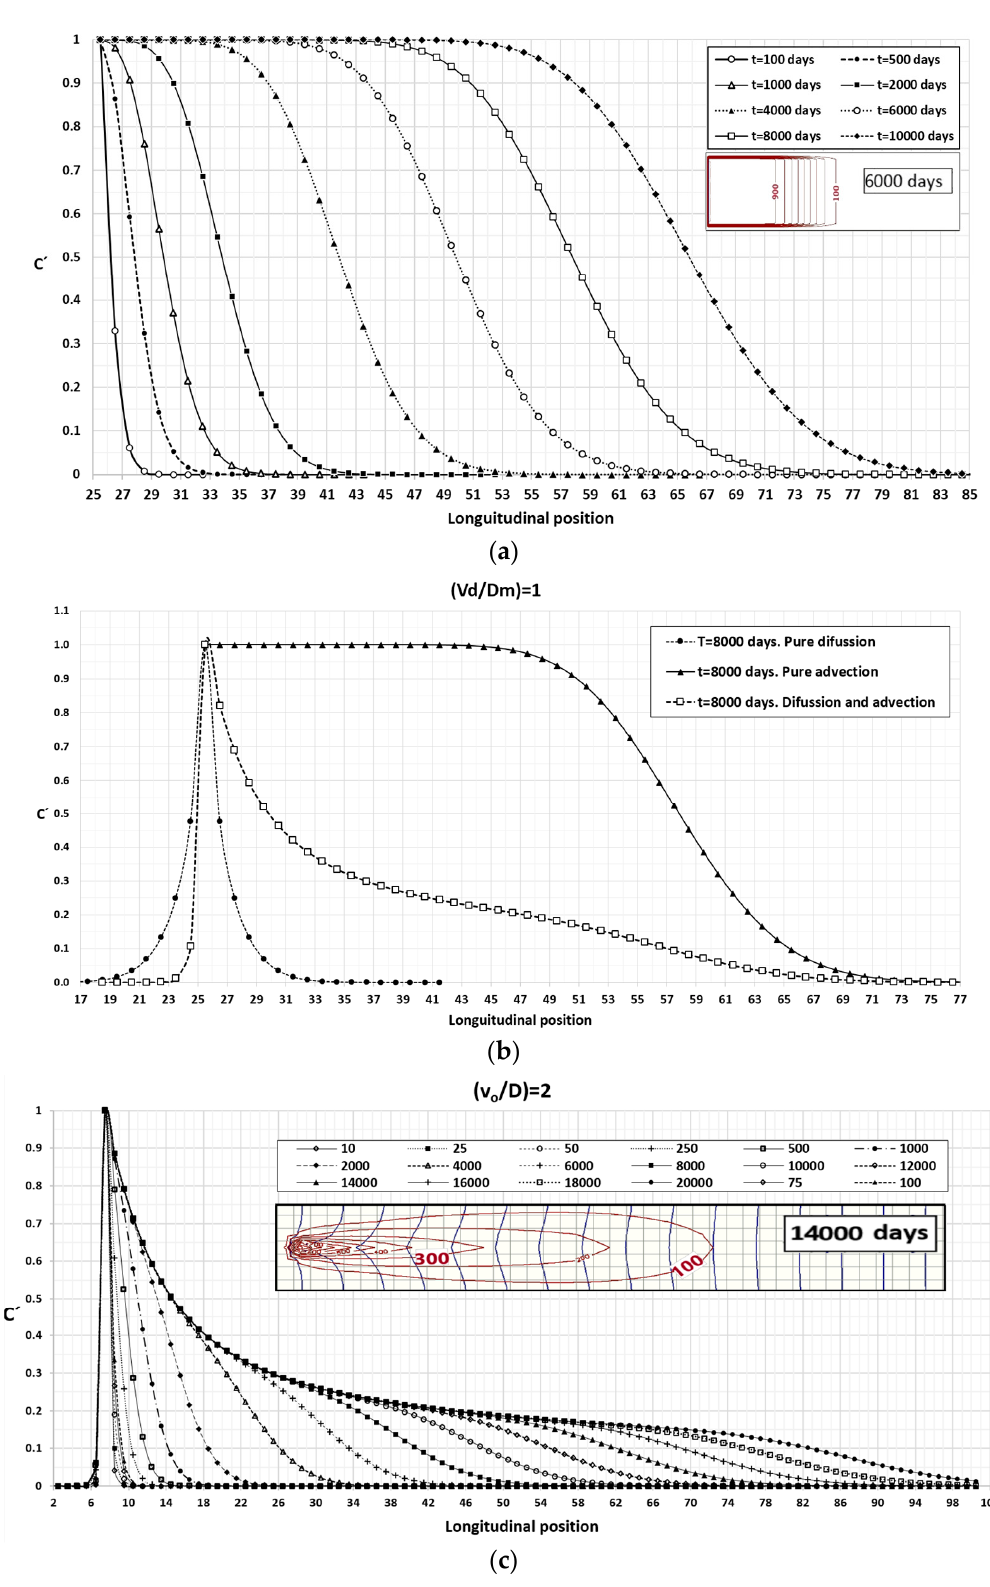
Figure 6. Concentration profiles. ( a ) Only advection, c = 1000 kg/m 3 and vo = 0.0006 m/d. ( b ) For τ = 80 days, pure diffusion (D = 0.0006 m 2 /d), pure advection (vo = 0.0006 m/d) and advection-diffusion (D = 0.0006 m 2 /d, vo = 0.0006 m/d). ( c ) Coupled problem, D = 0.0003 m 2 /d and vo = 0.0006 m/d.